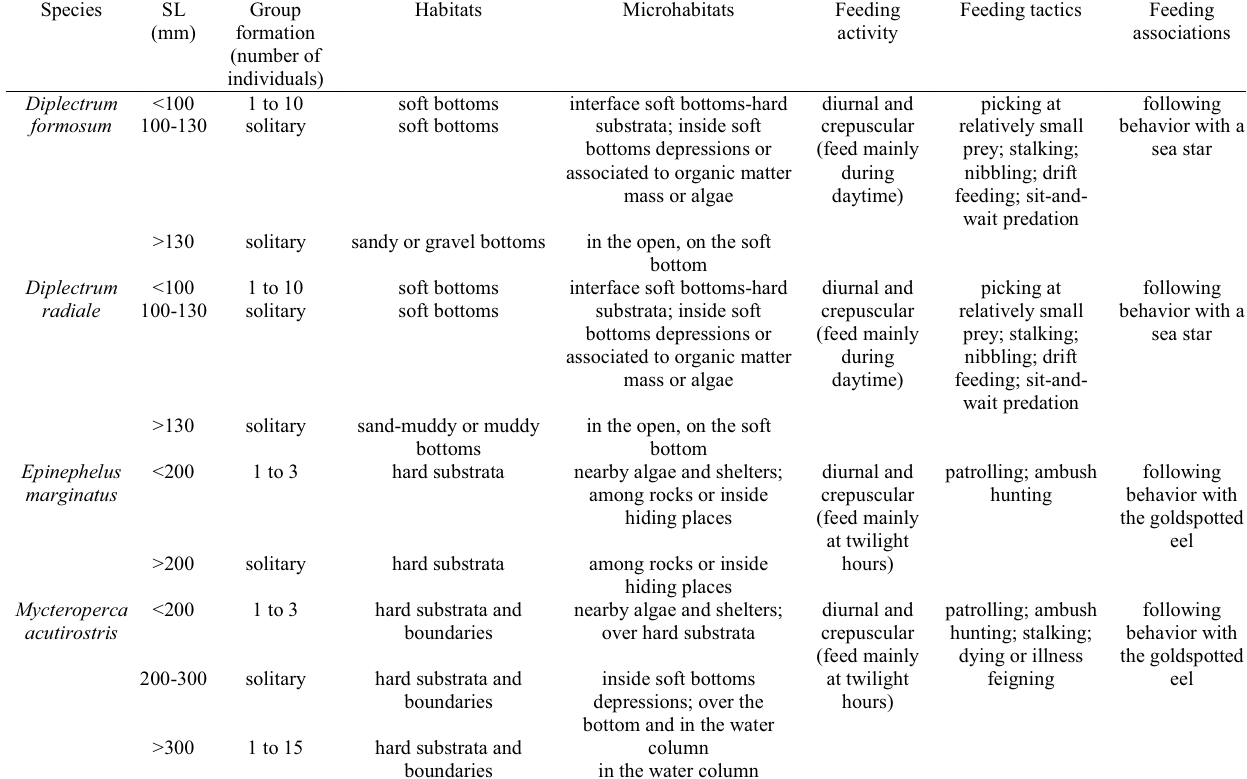
Table 2. Synthesis of the results obtained during the underwater observations. Each line of the group formation, habitats and microhabitats is in accordance to each size category of the standard length column